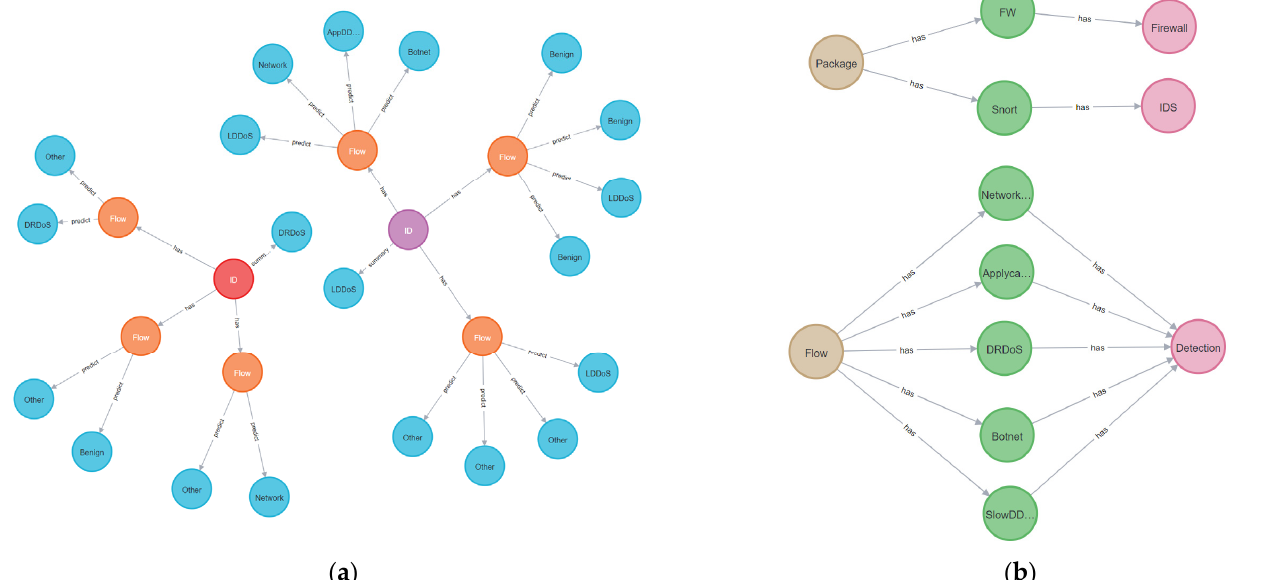
Figure 15. Data display of malicious behavior knowledge base. ( a ) Malicious traffic detection graph. ( b ) NSF Capability Graph.